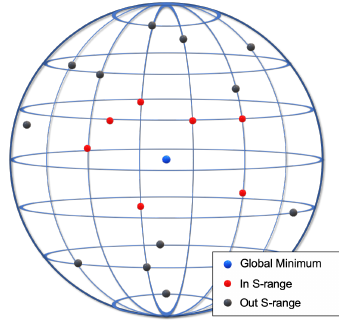
Figure 5. Behavior of epicenters around the best